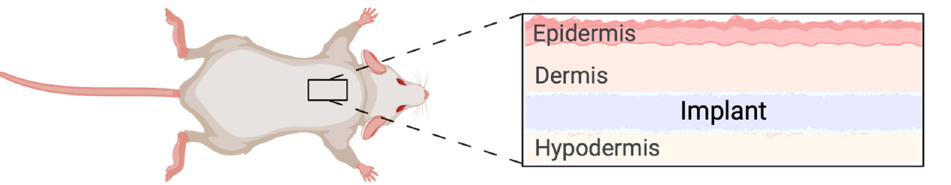
Figure 1. Schematic representation of implant placement in the in vivo model. The implant was inserted in a subcutaneous pocket in the dorsal thoracic area. The placement ensured the animal was not able to easily access the wound and cause harm to the area that was being monitored.